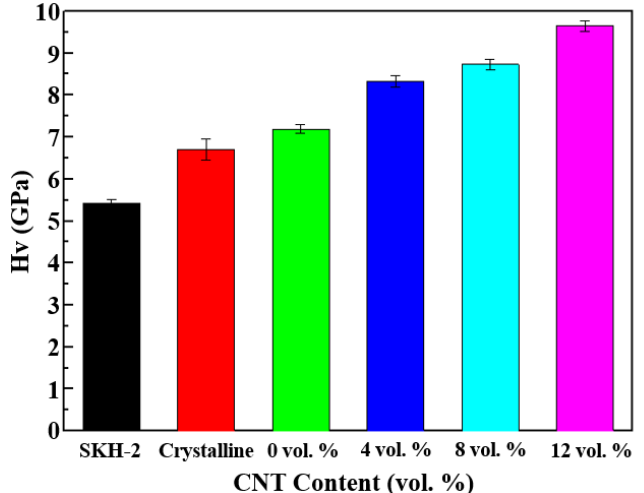
Figure 6. Microhardness of SKH-2 steel, crystalline Ti-based alloy, and CNT/Ti 50 Cu 28 Ni 15 Sn 7 BMG composite specimens. Hv: The Vickers hardness number.